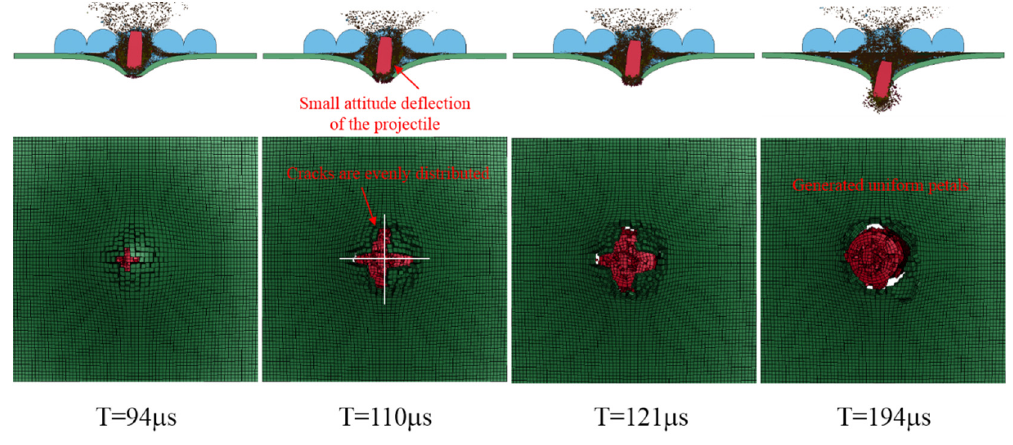
Figure 17. Deformation and failure process of the back plate under working condition 17.